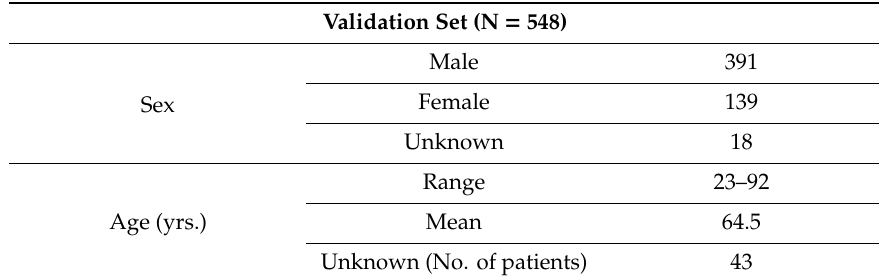
Table 2. Validation set clinical characteristics composed of GSE72872, GSE30601, GSE32925, GSE81334, GSE25869, and GSE31788 datasets.